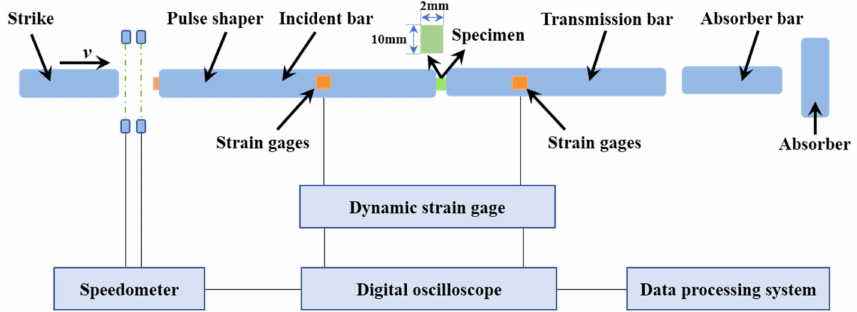
Figure 3. A sketch of the SHPB